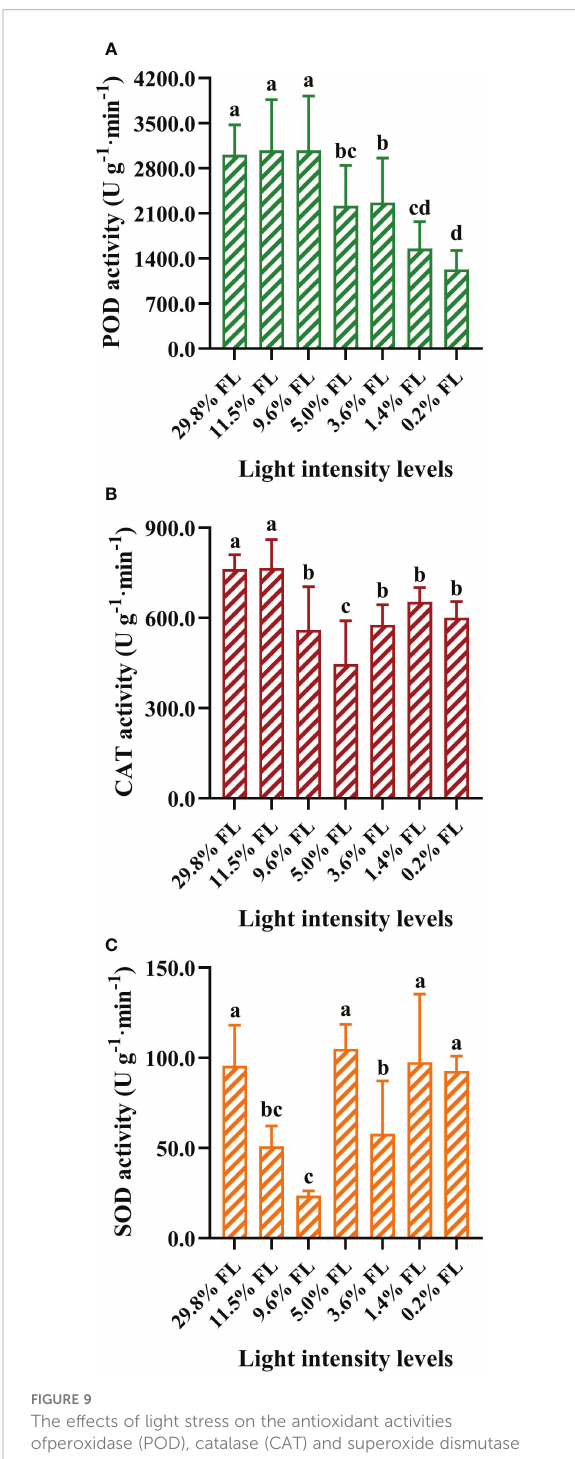
FIGURE 9 The effects of light stress on the antioxidant activities ofperoxidase (POD), catalase (CAT) and superoxide dismutase (SOD) in the leaves of P. notoginseng. (A) POD activity (U g - 1 ·min -1 ). (B) CAT activity (U g -1 ·min -1 ). (C) SOD activity (U g -1 ·min - 1 ). Values for each point were means ± SD ( n = 7). Letters indicate signi fi cant differences at P < 0.05 according to Duncan ’ s multiple range